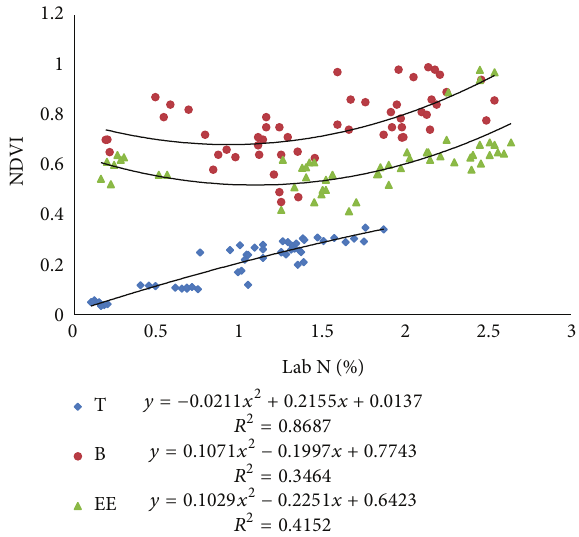
Figure 9: Correlations between NDVI calculated from N-sensor data and Lab N at different crop growth stages.